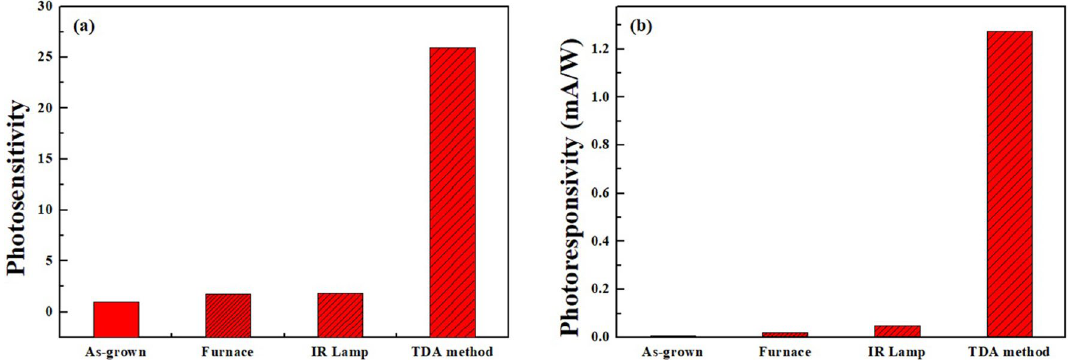
Figure 8. (a) Photosensitivity and (b) photoresponsivity of non-annealed ZnO thin films and annealed ZnO thin films by using furnace, IR lamp, and TDA